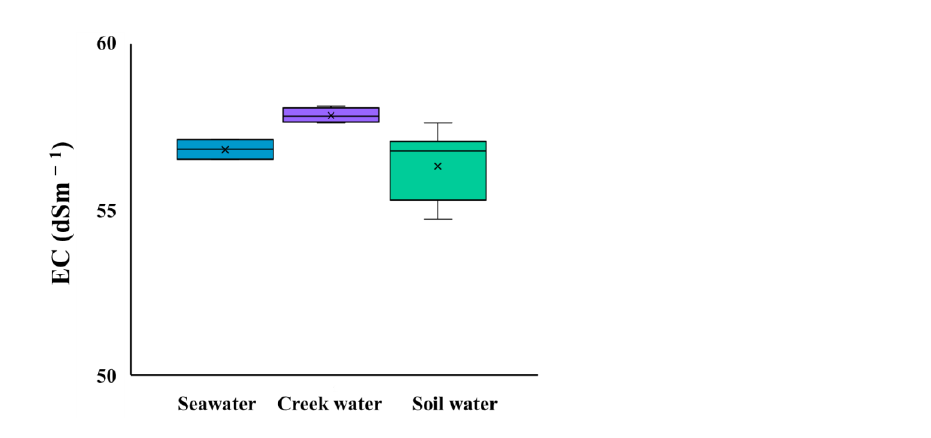
creek water on Moucha Island, Djibouti (Sep 12, 2019) .